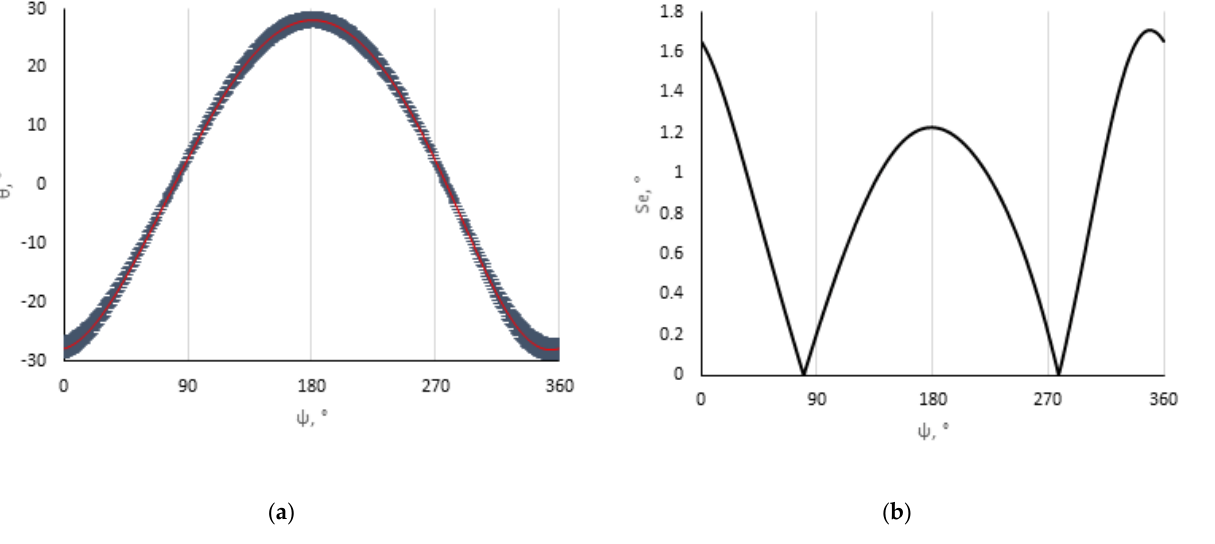
Figure 6. Curve illustrating: ( a ) values of composite quantity θ together with standard measuring uncertainty due to the measurement of e . ( b ) standard measuring uncertainty values for composite quantity θ due to the measurement of e .